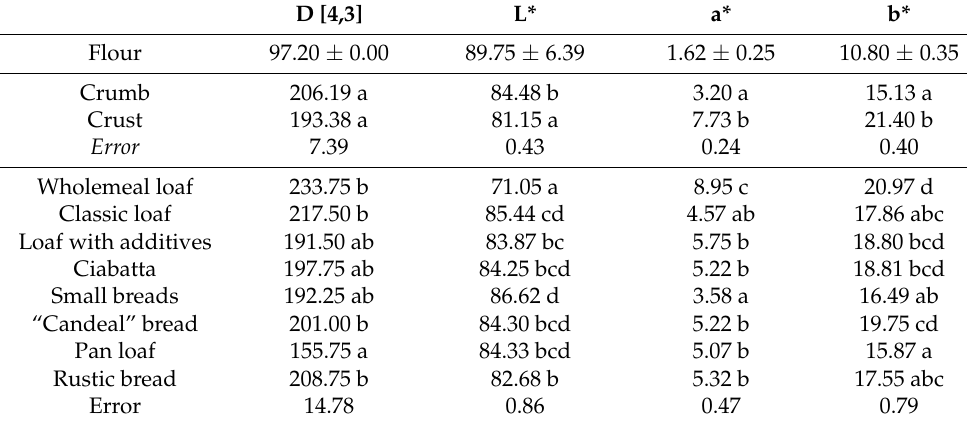
Table 2. Particle size and colour of the flours obtained.